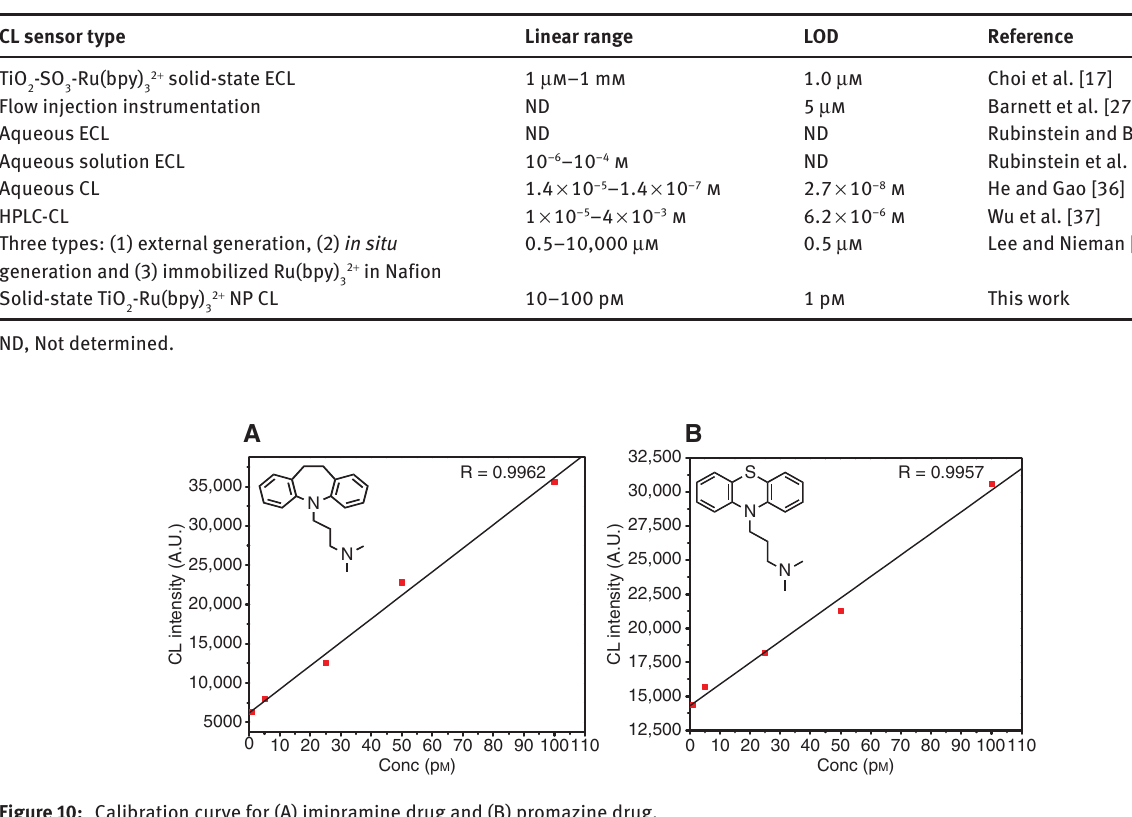
Figure 10: Calibration curve for (A) imipramine drug and (B) promazine drug. Conditions: 0.5 mm Ce(IV) and 200 ml/h flow rate. The structures of the drugs are also